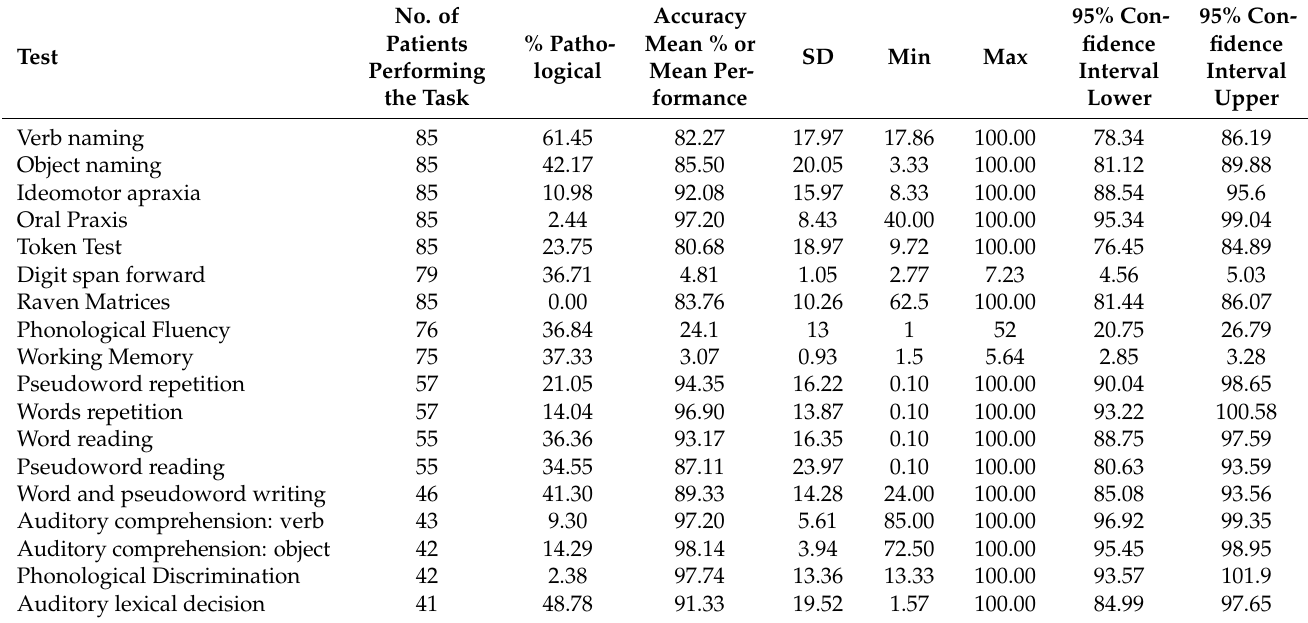
Table 3. All patients performed well on the Raven Matrices test, suggesting that their general intelligence was spared. Table 3. Neuropsychological performance (accuracy) of patients with left-hemisphere high-grade glioma